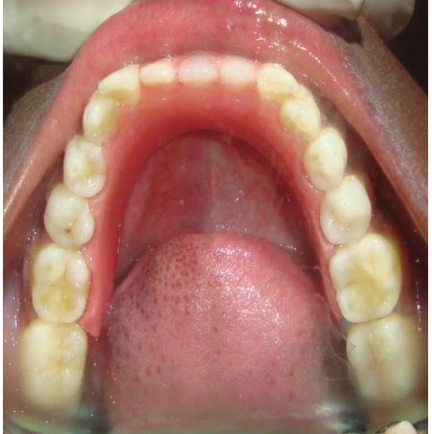
Figure 10: Posttreatment mandibular arch showing removable partial